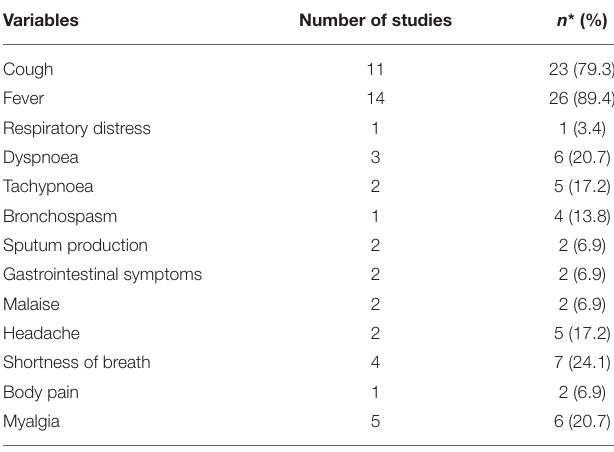
TABLE 5 | Clinical manifestation of co-infected patients in case reports/case series studies among a total of 29 evaluated patients. Variables